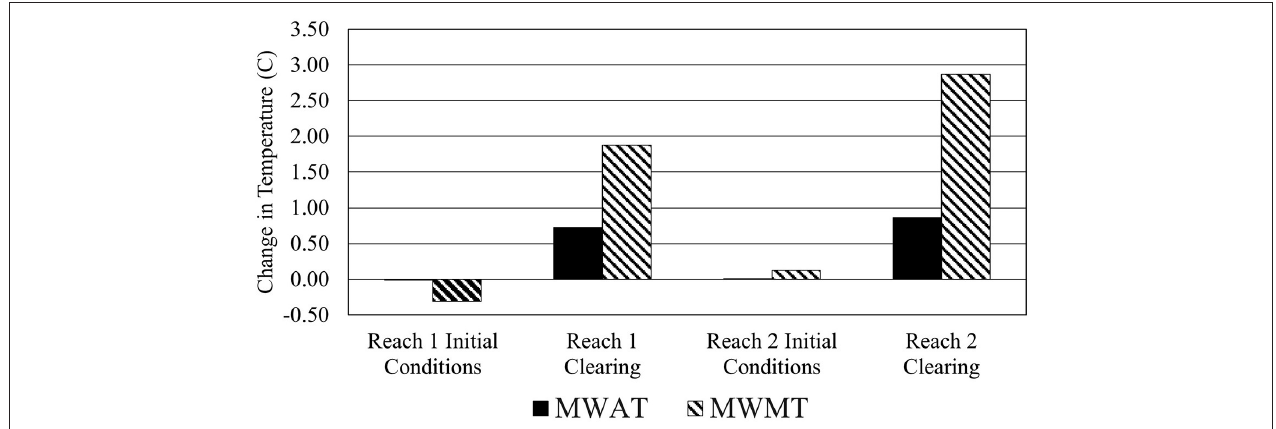
FIGURE 11 | Temperature ( ◦ C) difference when clearing isolated stream reaches to simulate converting alder dominated riparian zones to conifer dominated riparian